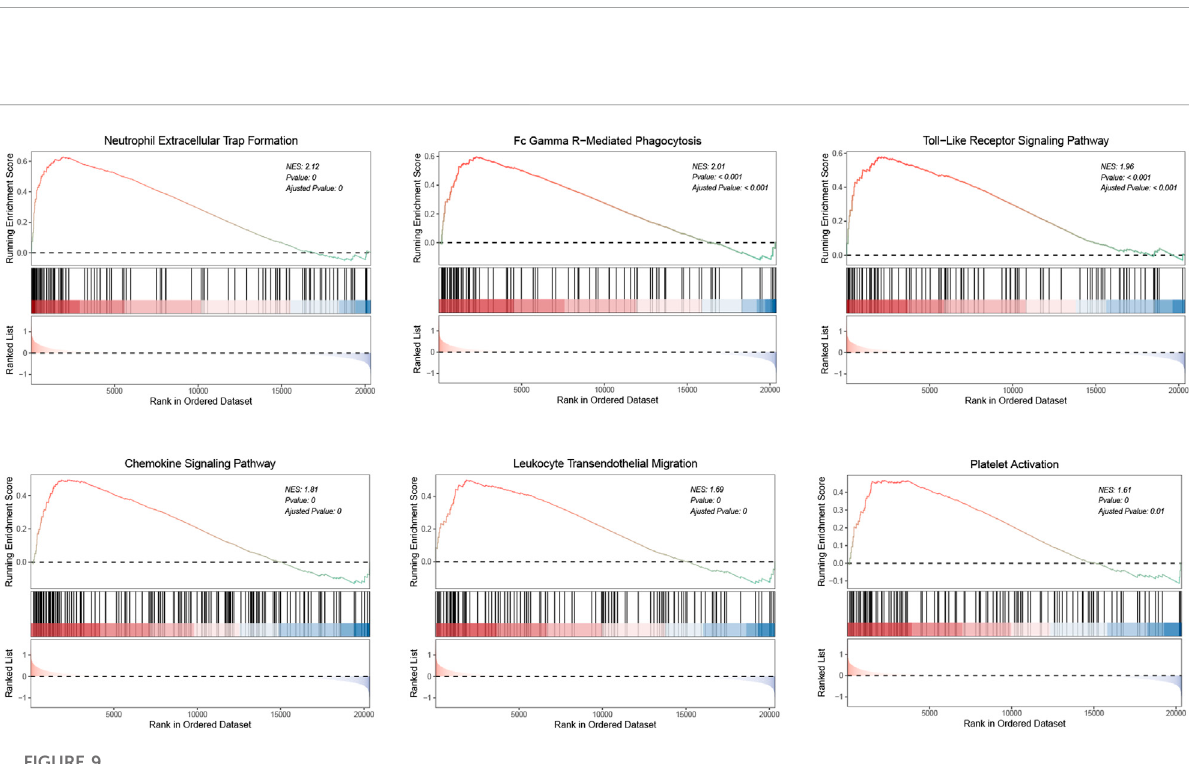
FIGURE 8 The receiver operating characteristic (ROC) curve of the diagnostic effectiveness of the six diagnostic markers. (A) ROC curve of six genes in GSE36791. (B) Validation the diagnostic value in GSE13353, GSE15629, and GSE 73378 dataset.